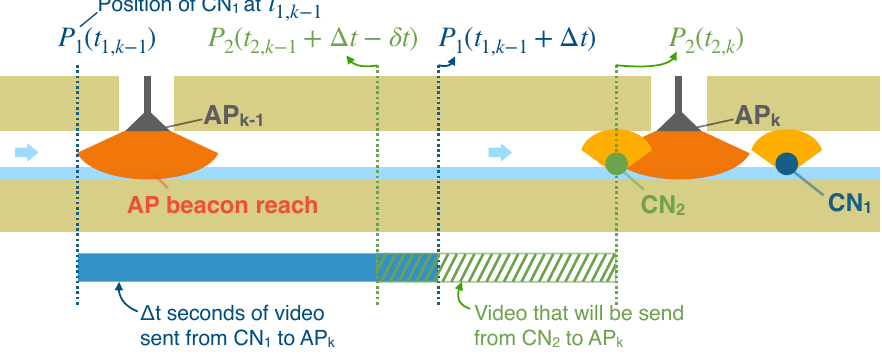
Figure 4. Example of transmission of video data from multiple CNs to AP k